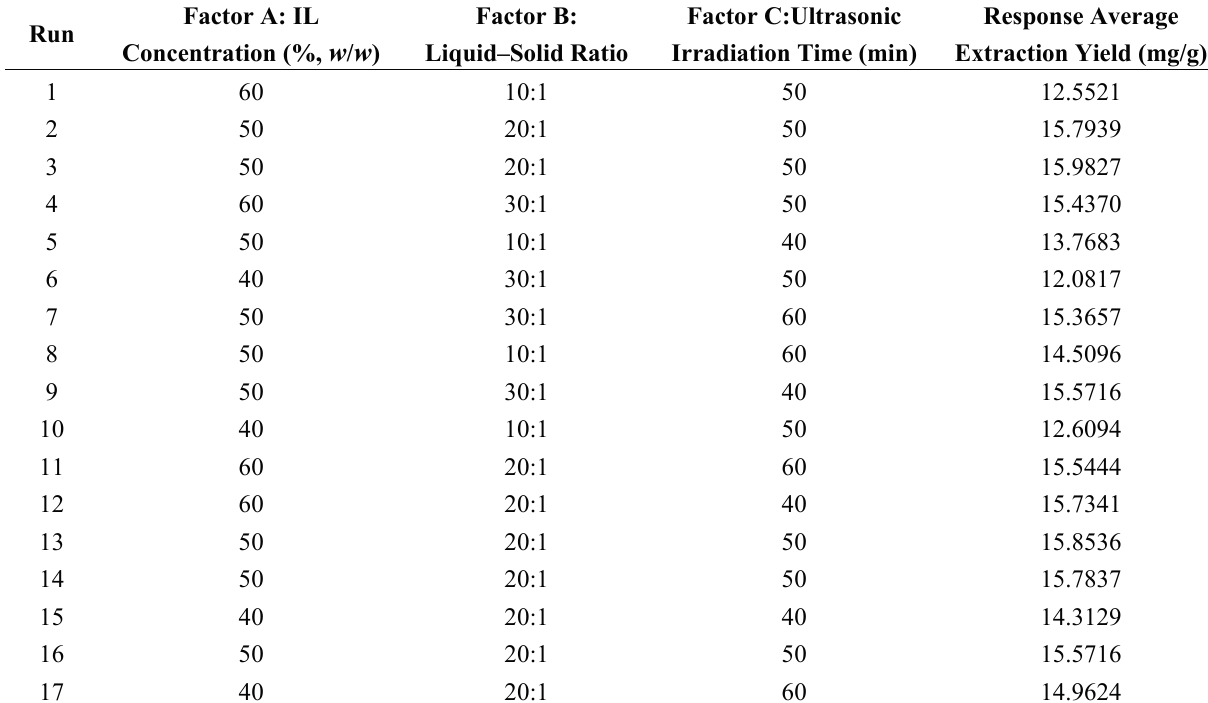
Table 1. Arrangement and results of the three-factor/three-level response surface